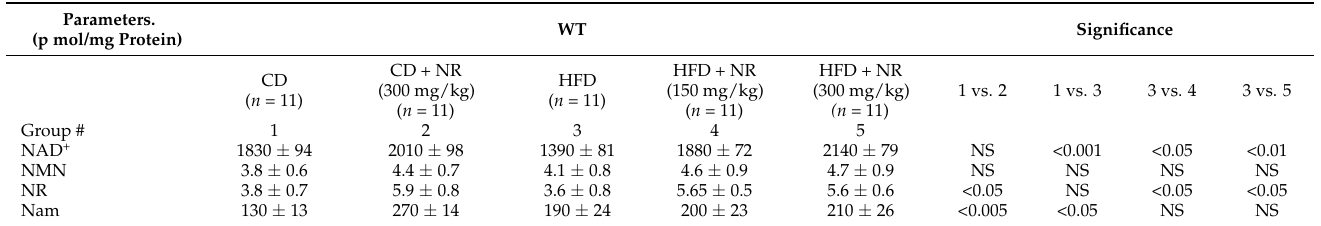
Table 4. NR, NMN, and NAD + Metabolites From DRG Extracts in CD, HFD or After 2 Months of NR Treatment. NS = Not